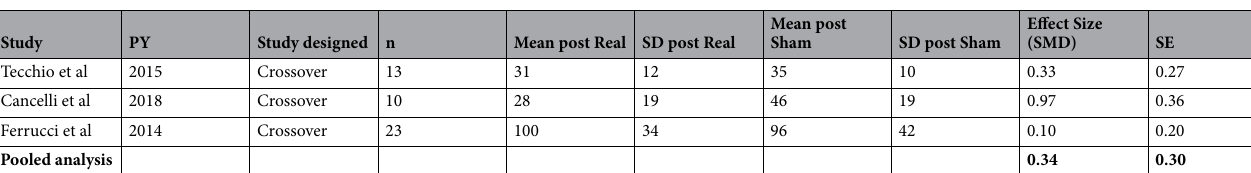
Table 9. Fatigue. Real Vs Sham. PY = Publication Year. SMD = Standardized Mean Difference. SE = Standard Error.